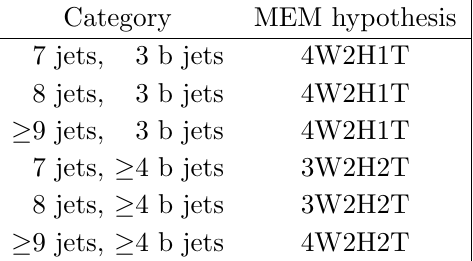
Table 2 . Selected MEM hypotheses for each event topology. The 4W2H1T hypothesis assumes 1 b quark from a top quark is lost, 3W2H2T assumes that 1 quark from a W boson is lost, and 4W2H2T represents the fully reconstructed hypothesis requiring at least 8